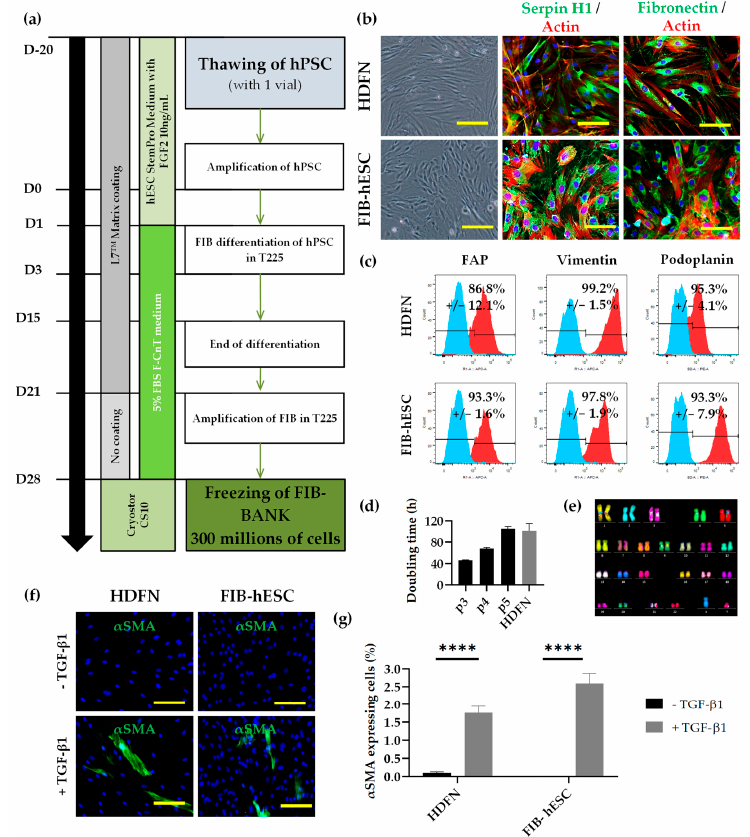
Figure 2. Characterization of a homogeneous and functional population of fibroblasts derived from hESC. ( a ) Schematic representation of the clinical compatible protocol design for differentiation of hPSC into fibroblasts. ( b ) Microscopic observation of HDFN and FIB-hESC morphology (Scale bars: 200 μ m) and immunocytochemistry analysis of Serpin H1 and Fibronectin (Scale bars: 100 μ m). The cell’s shape was observed with actin staining (in red). ( c ) Flow cytometry analysis of FAP, Vimentin, and Podoplanin (in red). Staining with isotypic antibody (in blue) was performed as control. ( d ) Doubling time of FIB-hESC from passage 3 (p3) until p5 and HDFNp4. ( e ) Karyotype analysis by